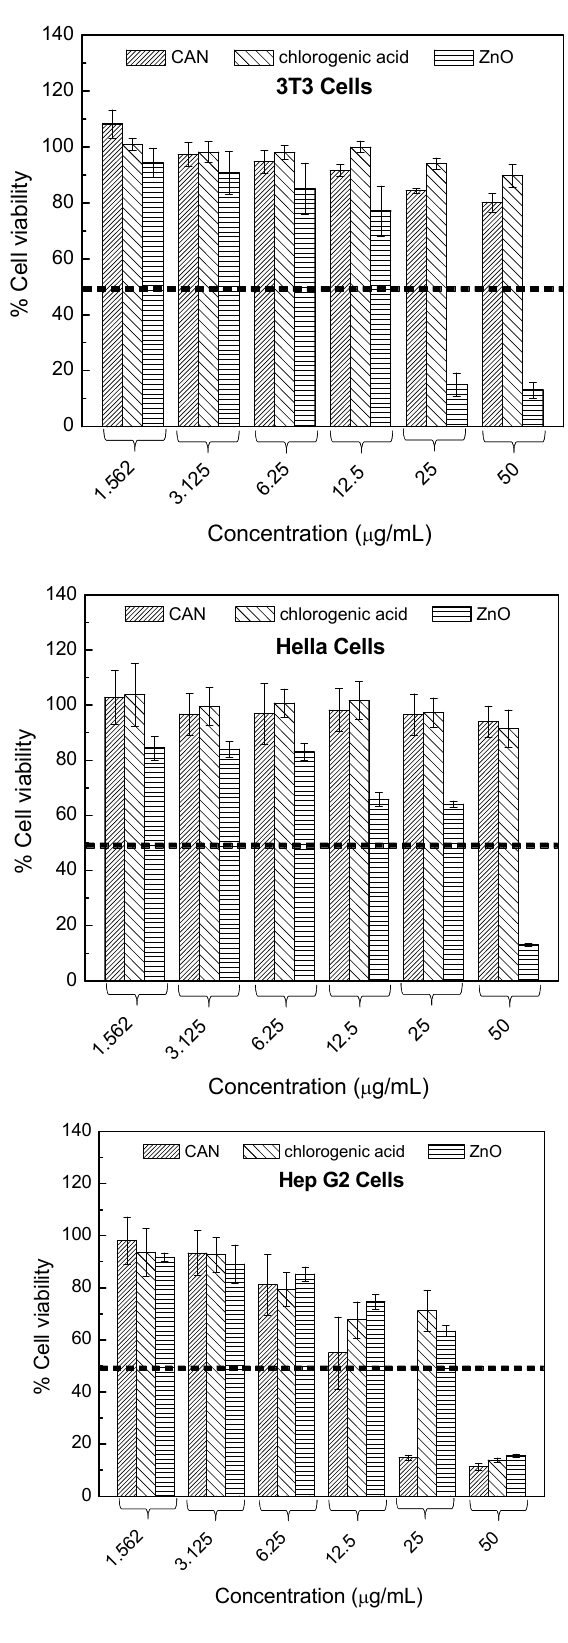
Figure 6. Cell viability (MTT assay) of 3T3, HeLa, MCF-7, A549, and Hep G2 cell lines exposed to various concentrations of chlorogenic acid nanohybrid, free chlorogenic acid and ZnO. (With permission from American Scientific Publisher, Valencia, CA,